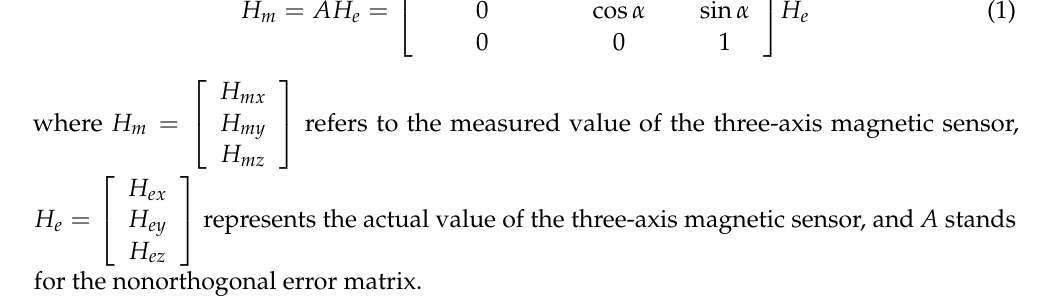
where H m =  refers to the measured value of the three-axis magnetic sensor,